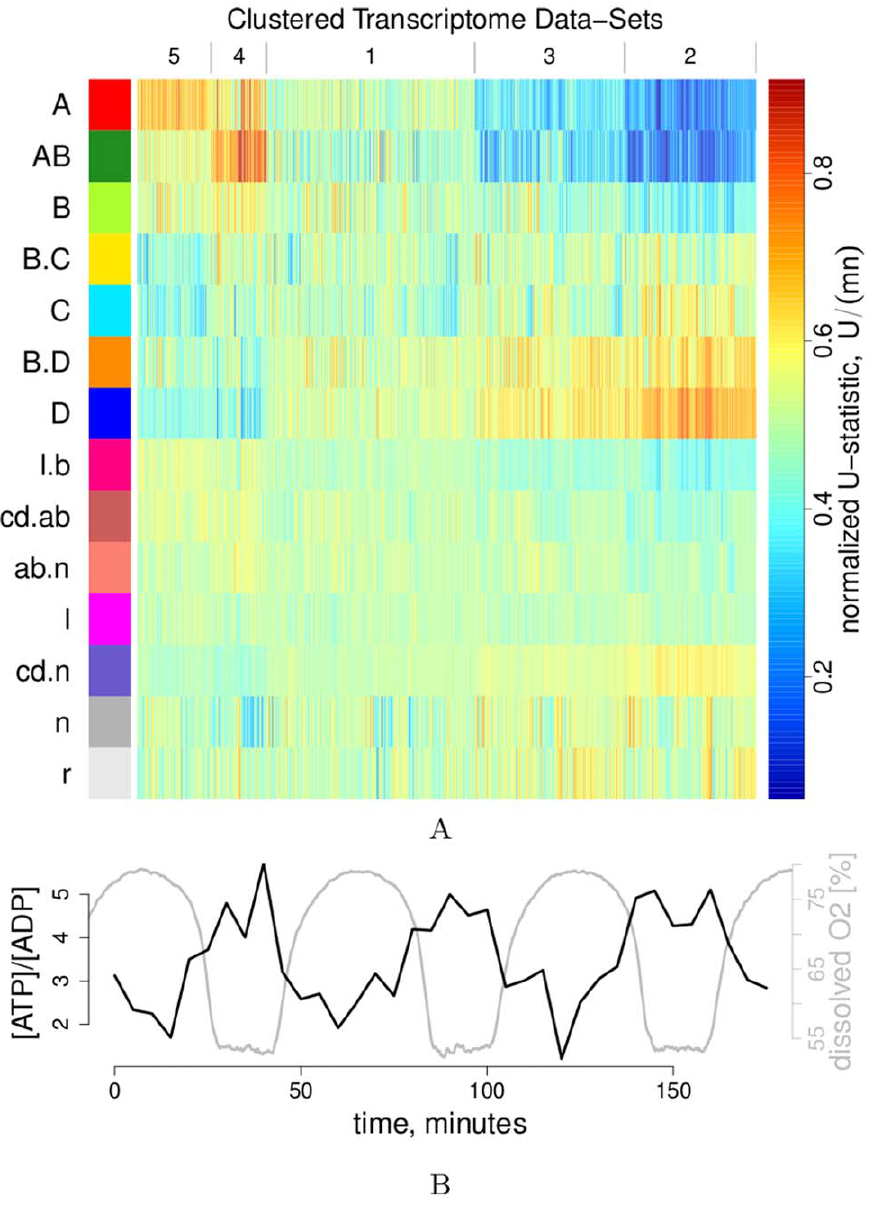
Figure 3. Cluster transcriptome meta-analysis & ATP:ADP ratio. 3A: Relative RNA expression profiles of redox clusters (rows) in a collection 1,327 microarray hybridization datasets [60] (columns). The normalized rank sum U mn indicates a bias of the cluster genes towards upregulation ( 1 w U mn w & 0 : 6 , red to yellow) or downregulation ( & 0 : 4 v U mn v 0 , cyan to blue) in the respective experiment. Experiments were sorted into 5 clusters (column numbers) by the SOTA algorithm [104] and plotted in decreasing order (from left to right) of the means of cluster A’s U mn values. The Dataset S3 gives SOTA assignments, U mn values and p-values from two-sided Mann-Whitney-Wilcoxon tests. 3B: The ATP:ADP ratio was measured enzymatically every 5 minutes over three cycles of a respiratory oscillation and culture system that corresponds to the 0.7 h period dataset (available as Dataset S8).